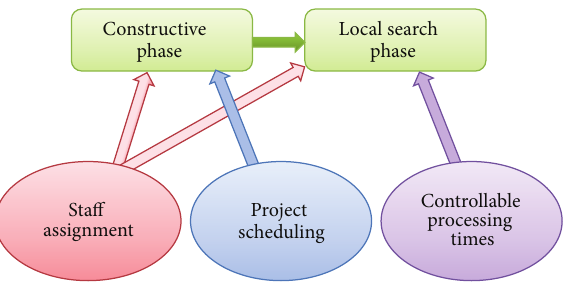
Figure 3: Division of the